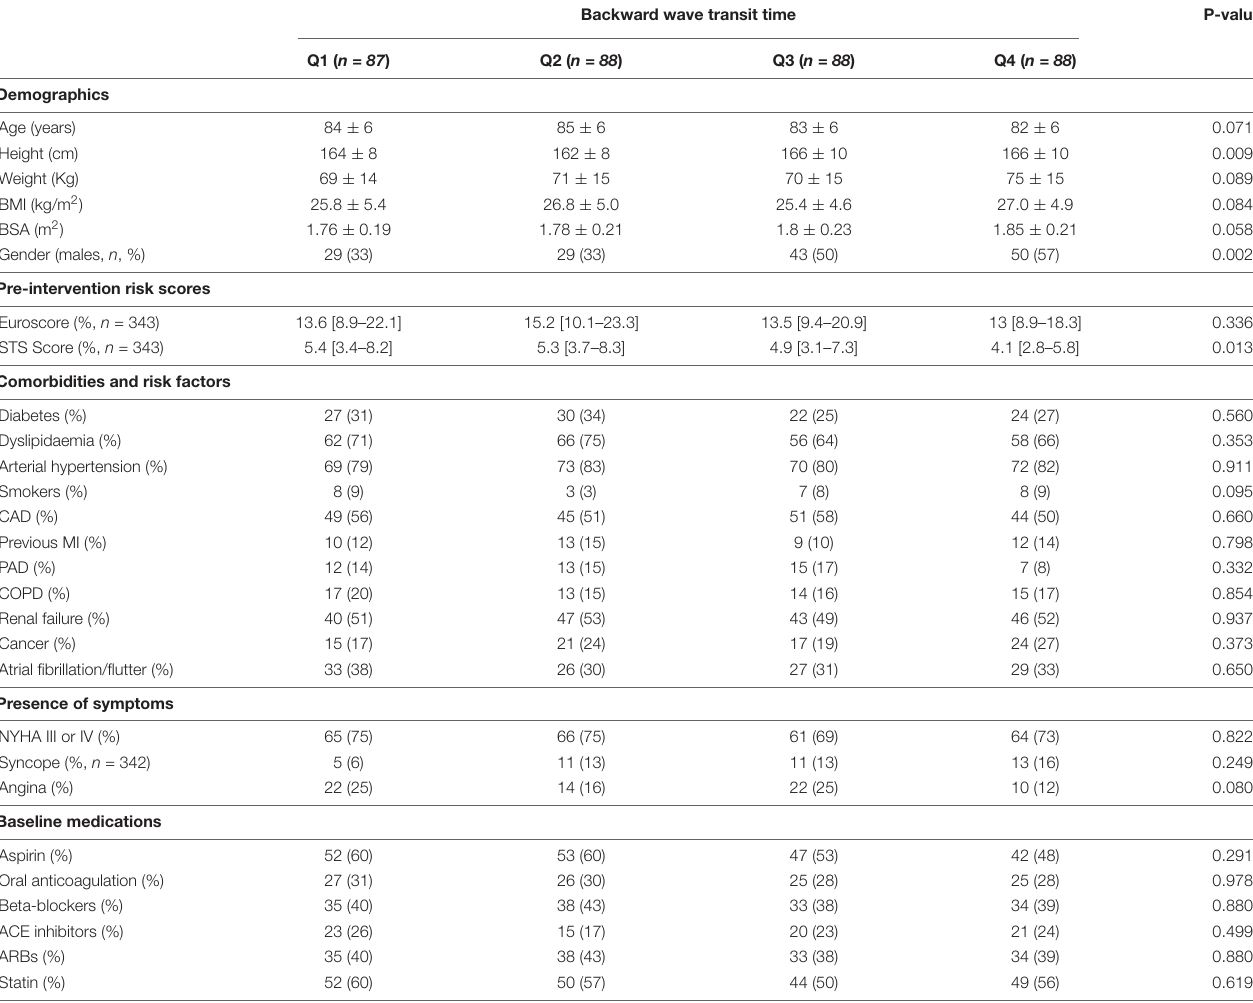
TABLE 1 | Demographic and clinical characteristics of the study population according to the BWTT